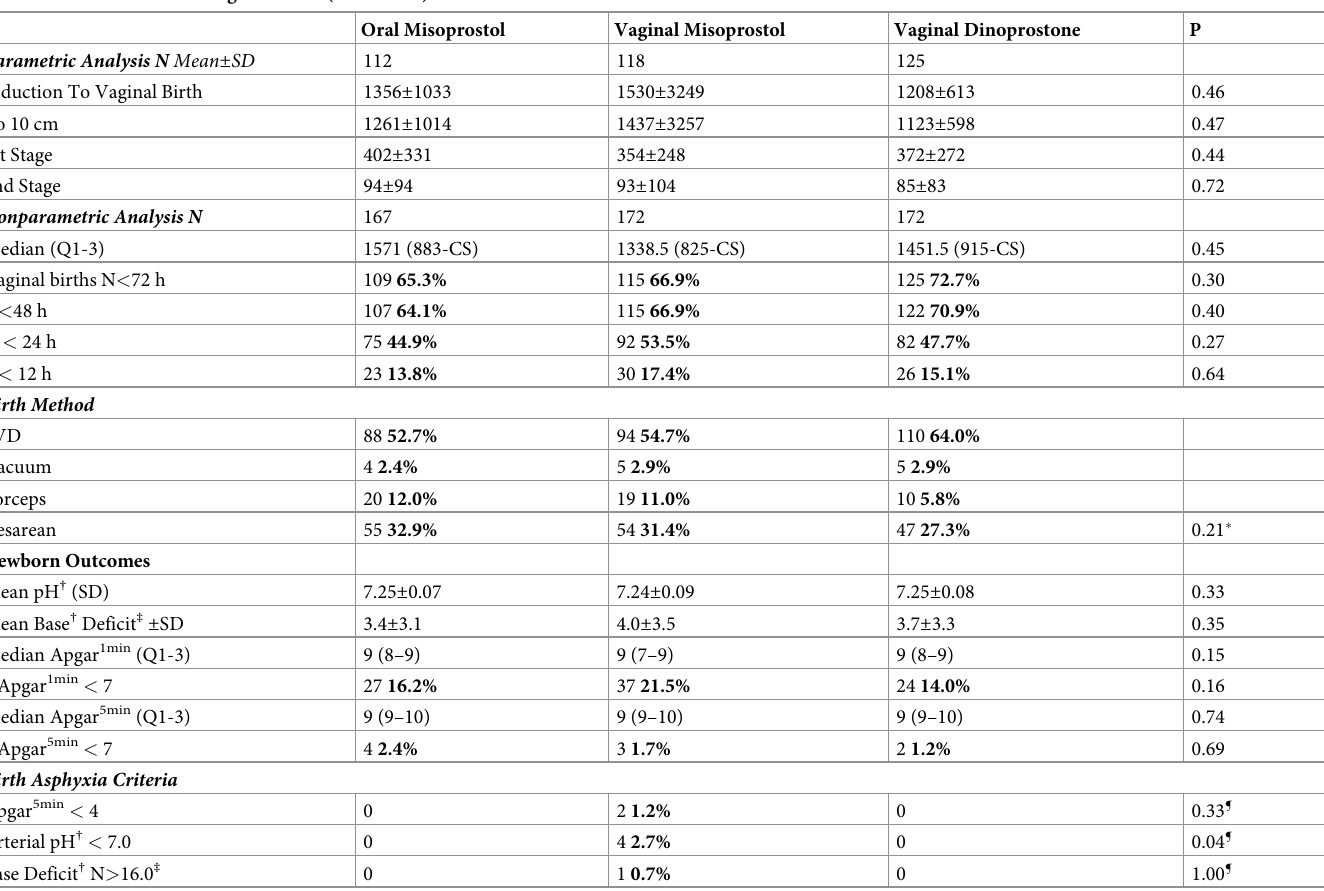
Table 3. Labor intervals to vaginal births (in minutes) and newborn